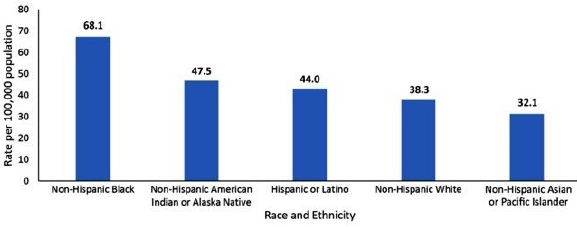
Figure 2. Age-adjusted Influenza-related Hospitalizations by Race/Ethnicity, 2009-2010 through 2018-2019 (Influenza Hospi- talization Surveillance Network, FluSurv-NET)